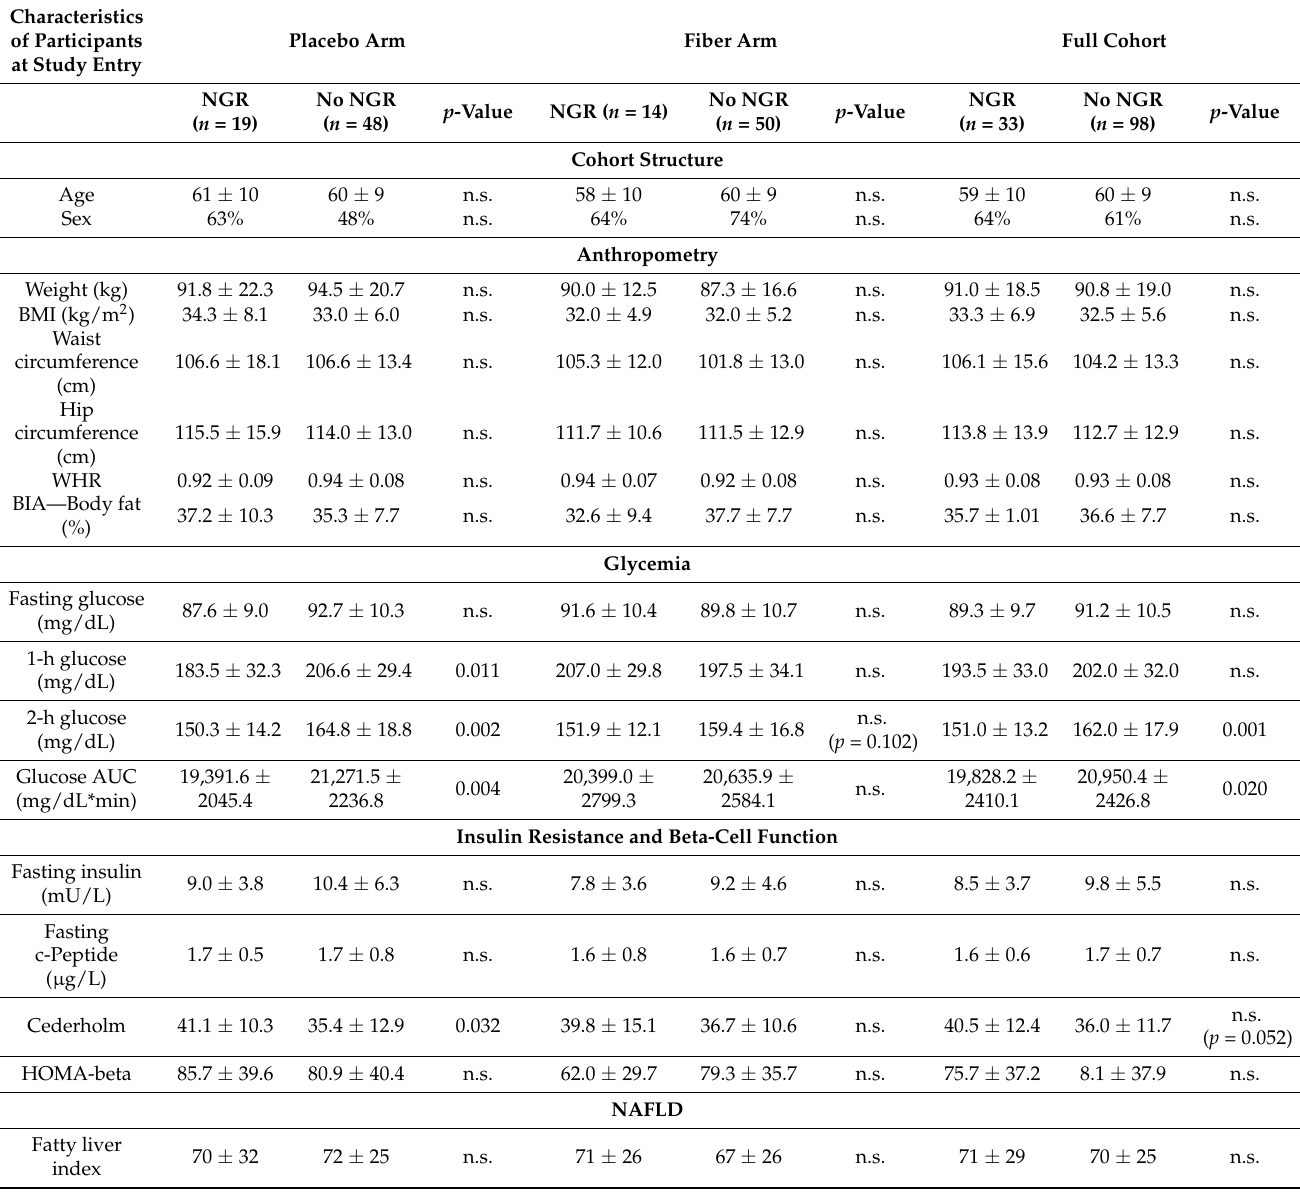
Table 1. Characteristics of responders and non-responders (NGR) at study entry; Mann–Whitney tests for comparison of NGR and non-NGR